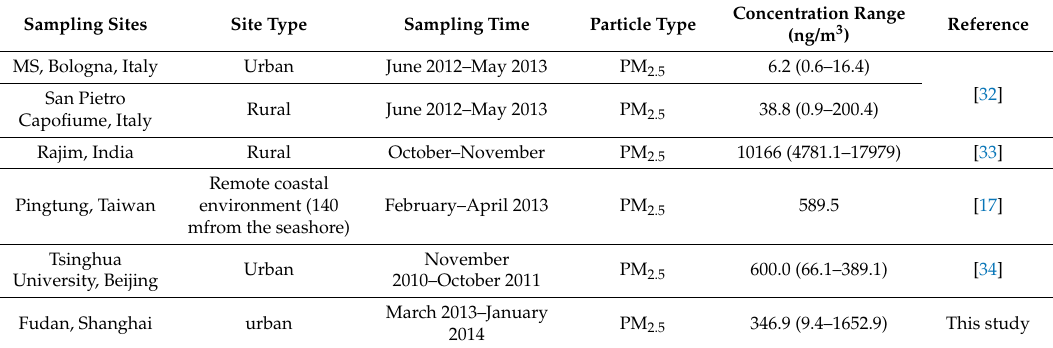
Table 2. Comparison of the saccharides in this study with those reported in the literatures (ng/m 3 ). Sampling